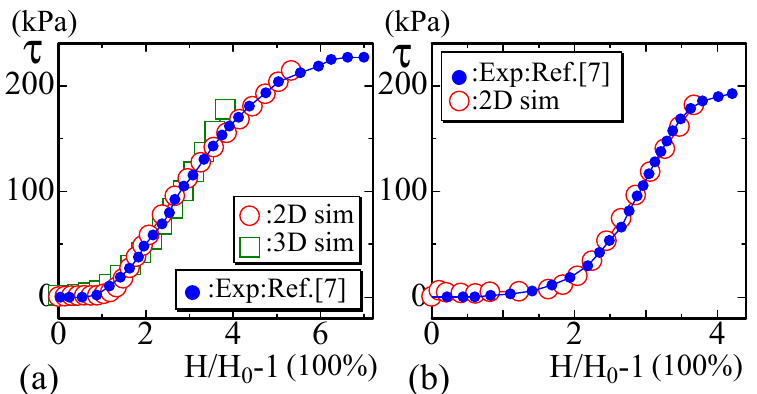
Figure 9. The stress vs. titin strain of animal’s ( a ) cardiac and ( b ) skeletal muscles, where the range of the toe region extends to 100 and 150% [9] and the curves have a convex part in the large-strain region. The strains are very large (up to 700%) compared to those of the other materials studied in this paper.